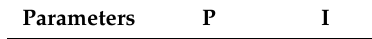
Table 2. Parameters used for the step reference.